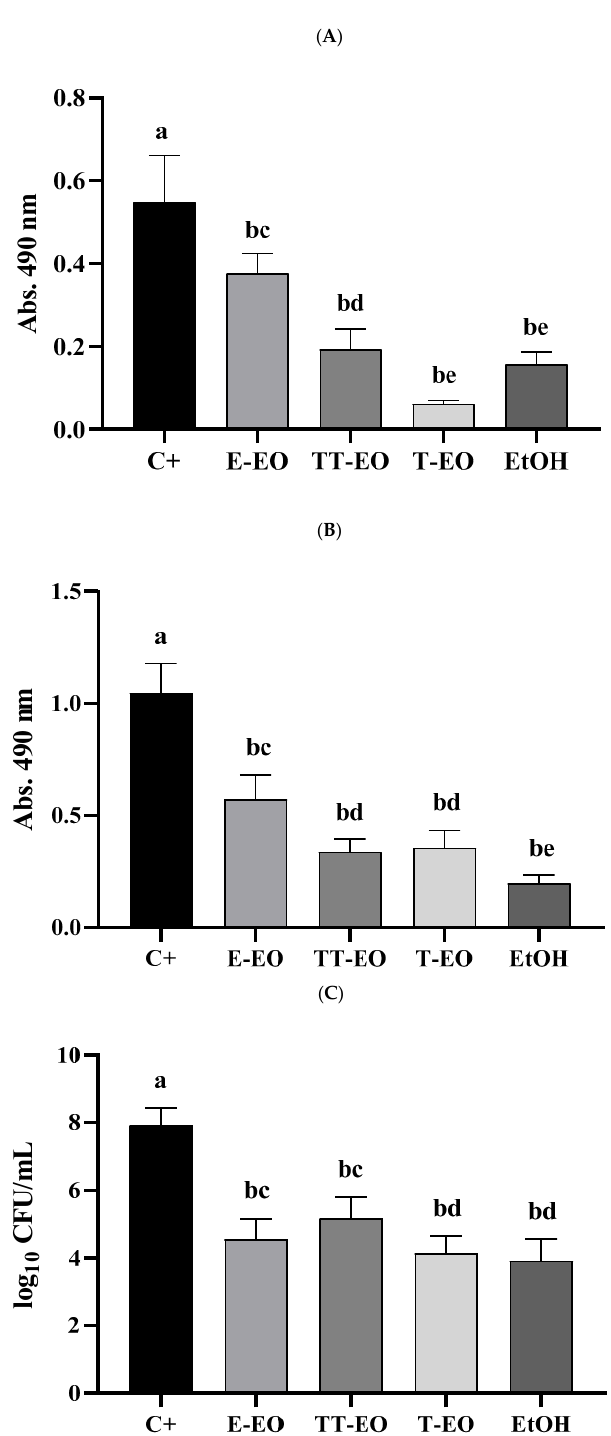
Figure 3. Antibiofilm activity of volatile fractions of essential oils (EOs) and ethanol against ( A ) S. aureus , ( B ) P. aeruginosa , and ( C ) C. albicans biofilm. C+—positive control of growth, i.e., biofilm treated with 0.9% saline, EtOH—suitability control setting, i.e., biofilm after treatment with ethanol fumes, E ‐ EO—biofilm after treatment with volatile fraction of eucalyptus oil, TT ‐ EO—biofilm after treatment with volatile fraction of tea ‐ tree oil, T ‐ EO—biofilm after treatment with volatile fraction of thyme oil. Values with different letters are significantly different ( p > 0.05, K–W test, followed by Tukey’s analysis): a, b—statistically significant differences between C+ and volatile fractions of EOs or ethanol; c, d, e—statistically significant differences between volatile fractions of EOs and ethanol.